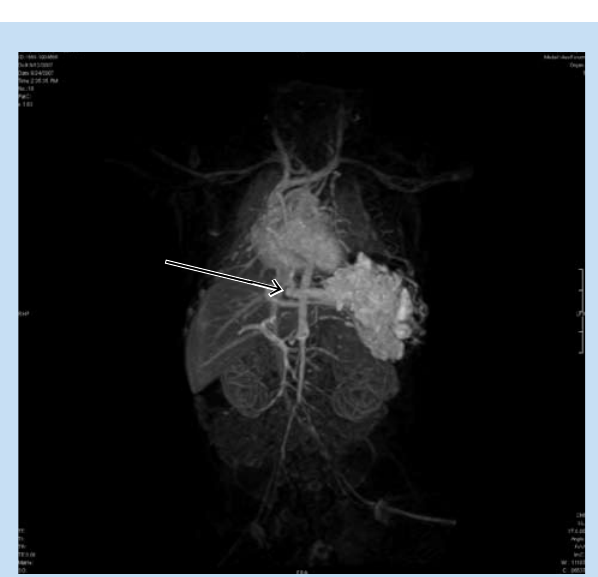
Fig. 4. Coronal MIP image. Delayed phase of contrast-enhanced MRA. Venous drainage to the IVC is shown (arrow).